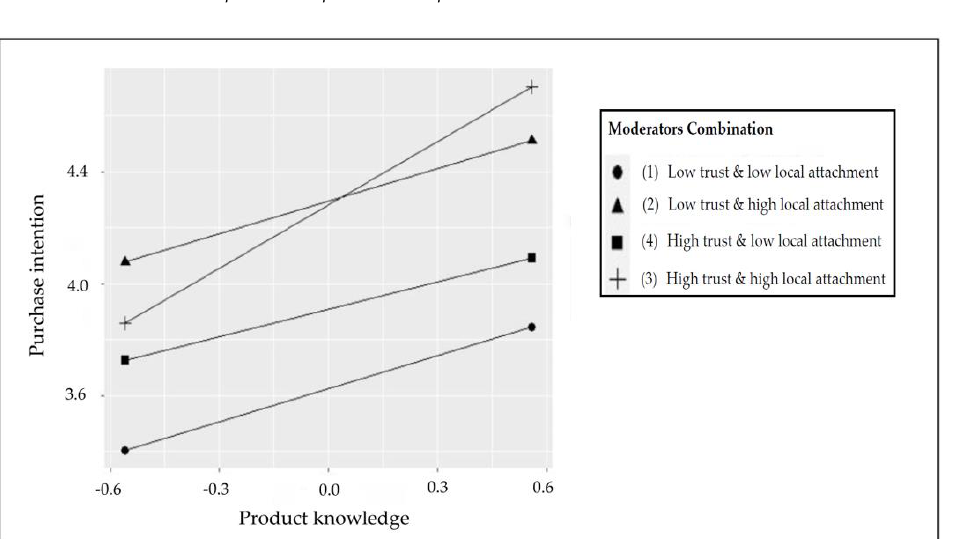
Figure 4. The interactive effects in three directions of local adherence and trust on “product knowledge and purchase